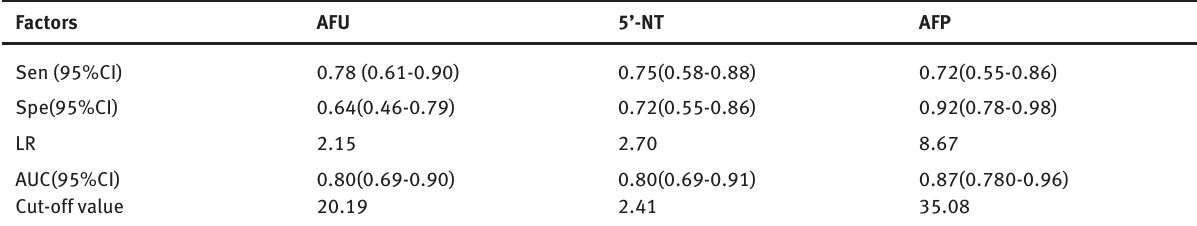
Table 1: The diagnostic value of serum AFU, 5’-NT and AFP for hepatocellular carcinoma